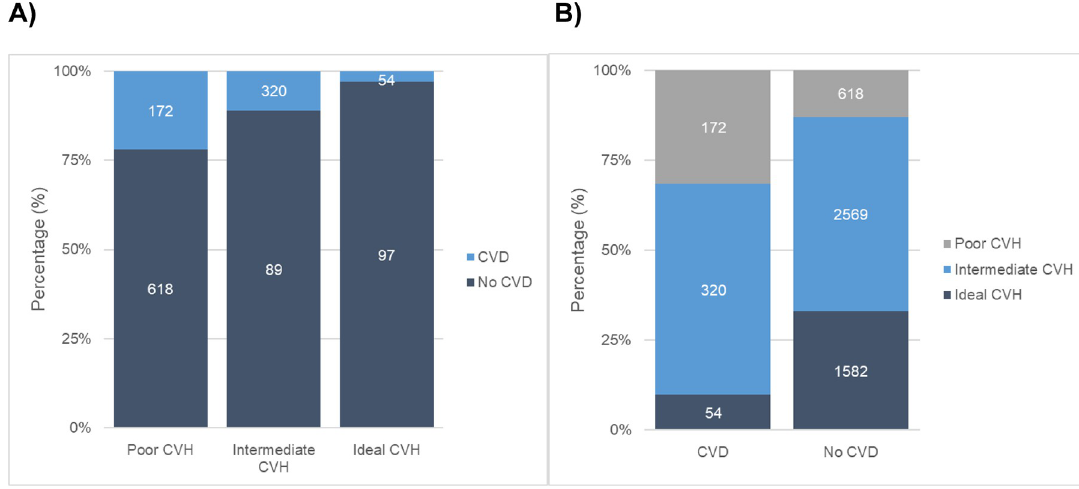
Fig 1. Pooled frequencies and percentages of: (A) Incident CVD by CVH status and (B) CVH status by incident